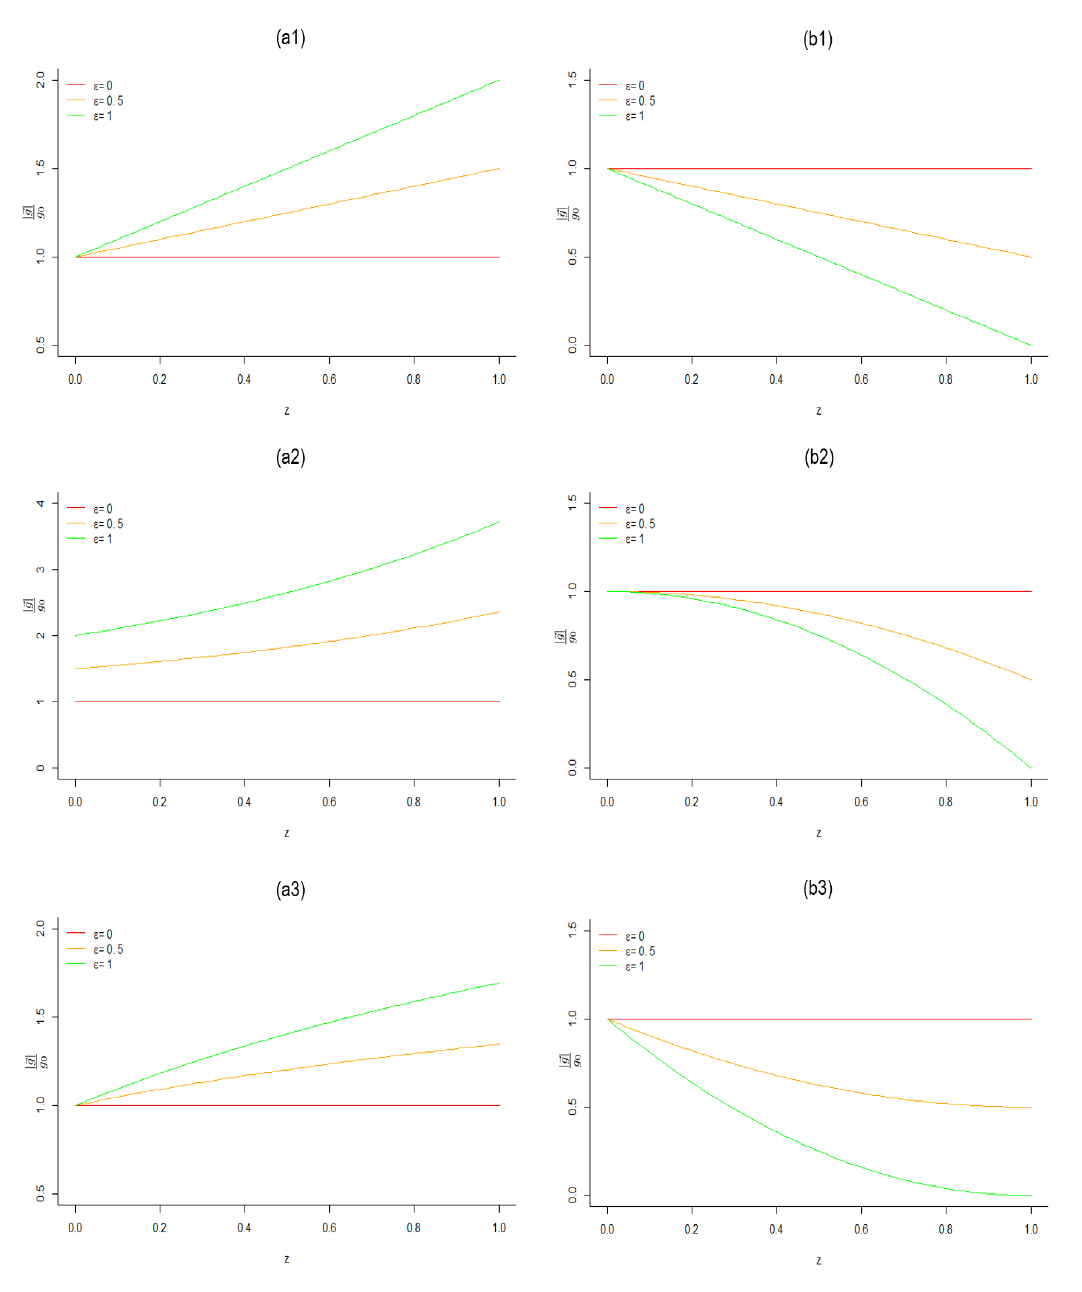
Figure 2. For different changeable gravity function, variation of | (cid:126) g | for f ( z ) = z in ( a1 ), f ( z ) = − z in ( b1 ), f ( z ) = e z in ( a2 ), f ( z ) = − z 2 in ( b2 ), f ( z ) = log ( 1 + z ) in ( a3 ) and f ( z ) = z 2 − 2 z in ( b3